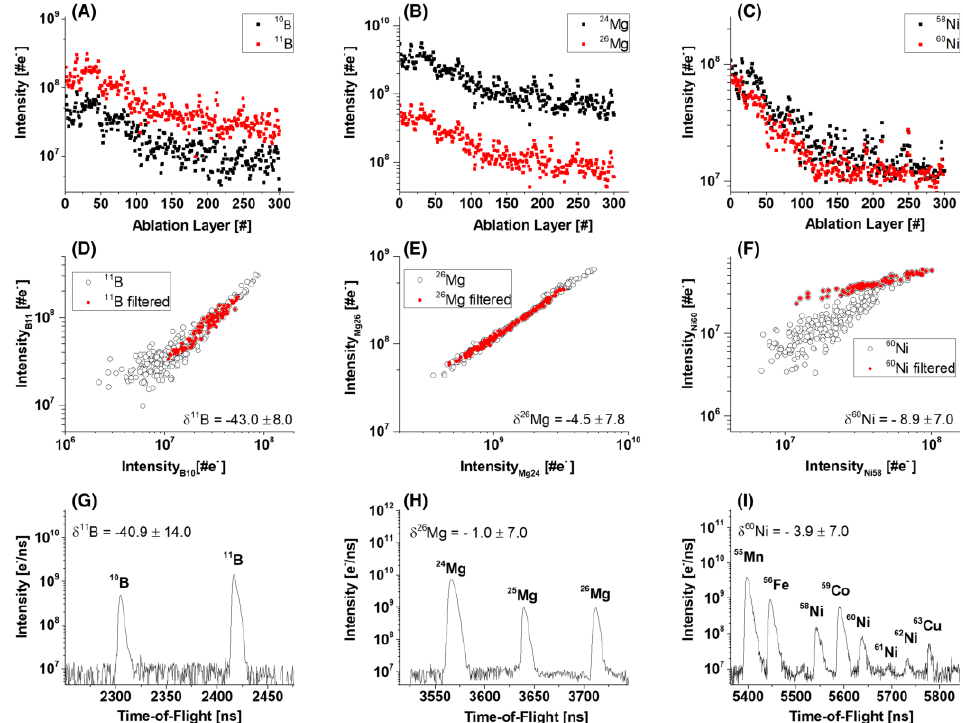
Figure 5. Panels ( A – C ) show depth profiles for the B, Mg and Ni isotopes at the location of a dark, micrometre-sized inclusion in the aragonite sample. Panels ( D – F ) show the isotope intensity correlations as raw data points (open circles) and after spectra filtering (full circles). Panels ( G – I ) show sections of the recorded time-of-flight spectra of the elements B, Mg and Ni with their isotopes. (Reproduced with the permission from the journal J. Mass Spectrom. [86]).